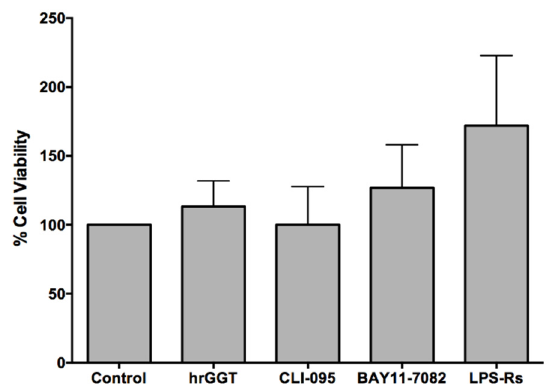
Figure 6. MTT assay in THP-1 cells after 4 h treatment with hrGGT (1 µg/mL) and several TLR4 signaling inhibitors (10 µg/mL LPS-Rs, 3 × 10 − 6 M CLI-095, and 10 − 5 M BAY-11-7082). Cell viability was reported as the absorbance ratio (expressed as a percentage) of treated cells to untreated cells. Data are presented as mean ± SEM ( n = 3).